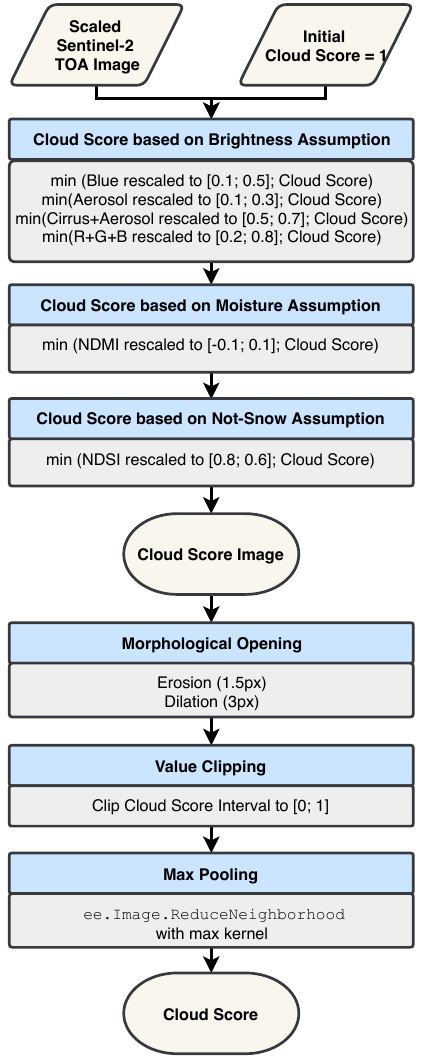
Figure 3. Flowchart of the Cloud Score module, which produces both a cloud score image containing pixel-wise cloud scores, as well as a scalar cloud score characterizing the whole image. Equ. 1, where S represents the current cloud score image and the rescaling range is defined as [ a, b ] .